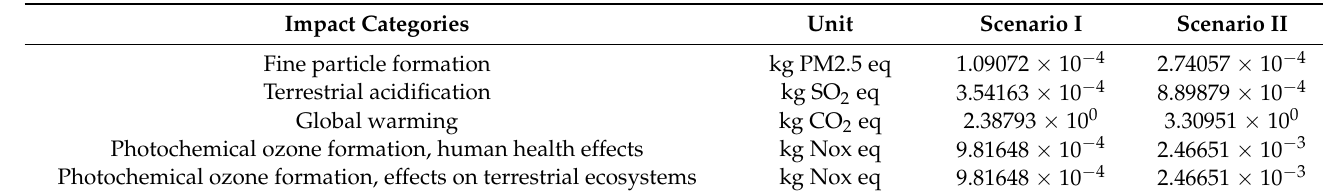
Table 2. Inputs and outputs of the MDP production for the two scenarios. Table 3. Impact categories of the MDP production process for the two